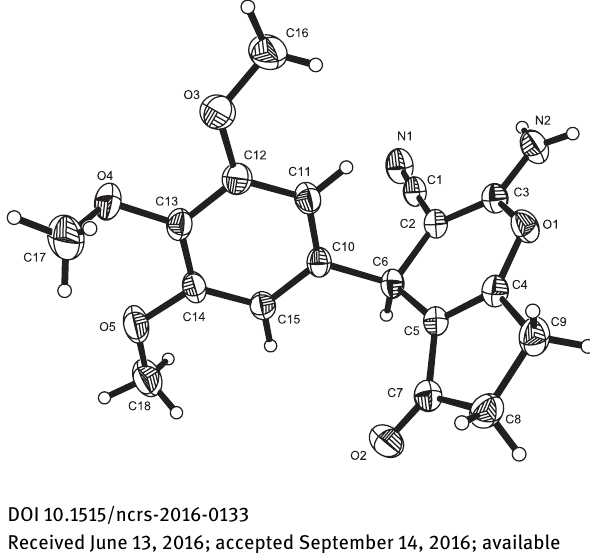
Table 1: Data collection and handling.